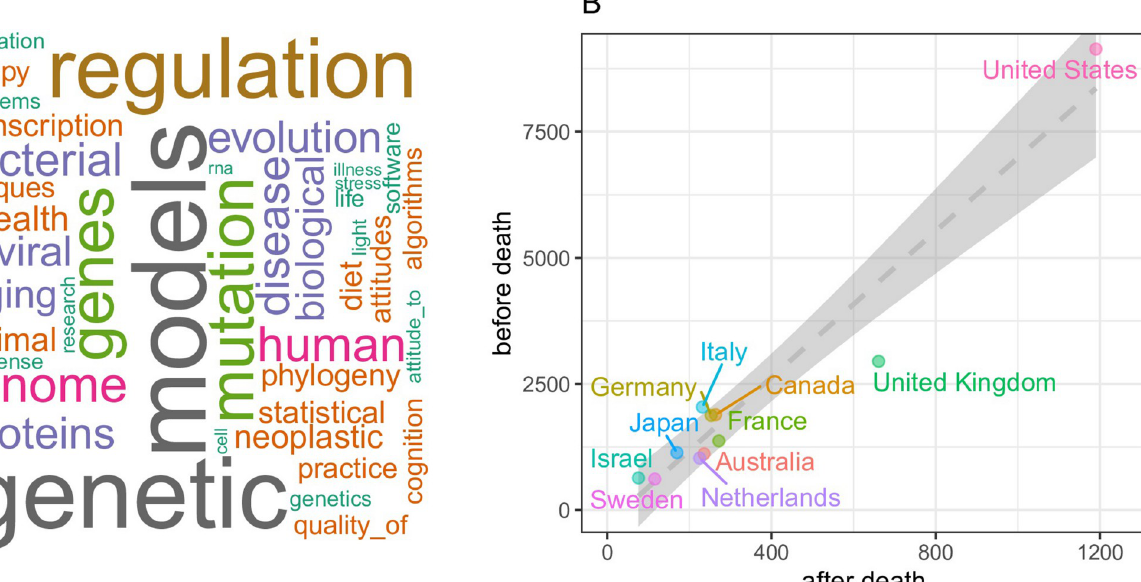
PLOS ONE | https://doi.org/10.1371/journal.pone.0273783 September 14,